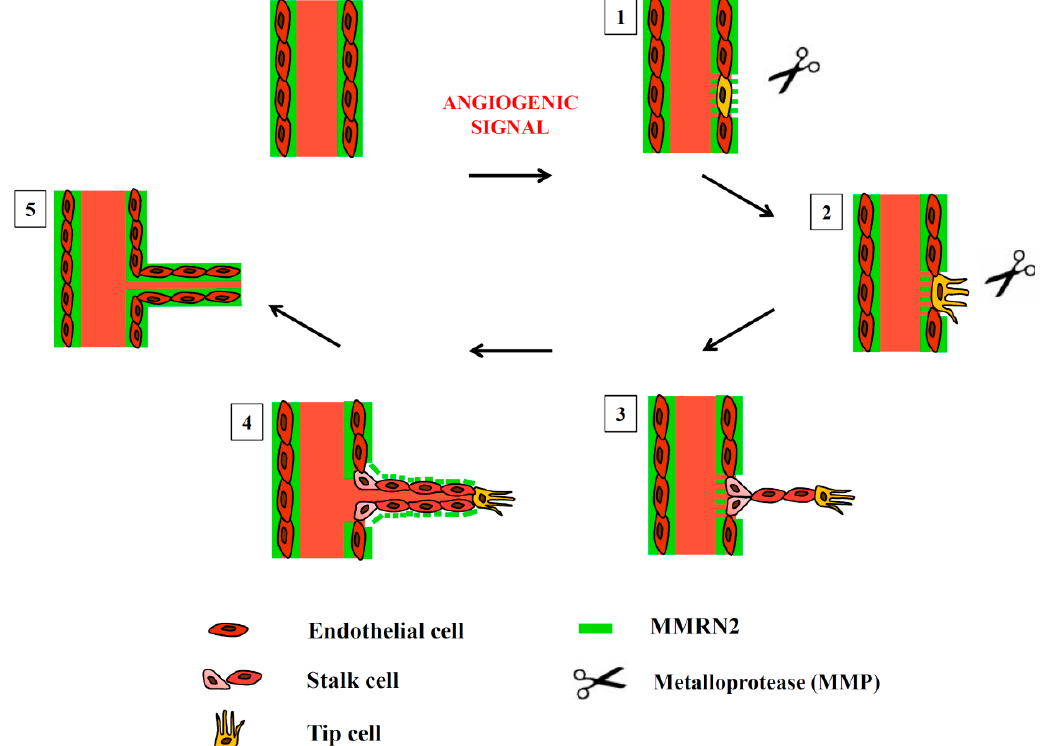
Figure 2. Schematic representation of the expression and degradation of MMRN2 during the steps involved in angiogenesis. (1) Following an angiogenic stimulus the basement membrane and MMRN2 are degraded by MMPs; (2) endothelial tip cells which drive sprouting angiogenesis are formed; (3) stalk cell proliferate and vessels’ lumen is formed; (4) ECs secrete MMRN2 stabilizing the vessels; (5) the quiescent state is restored.